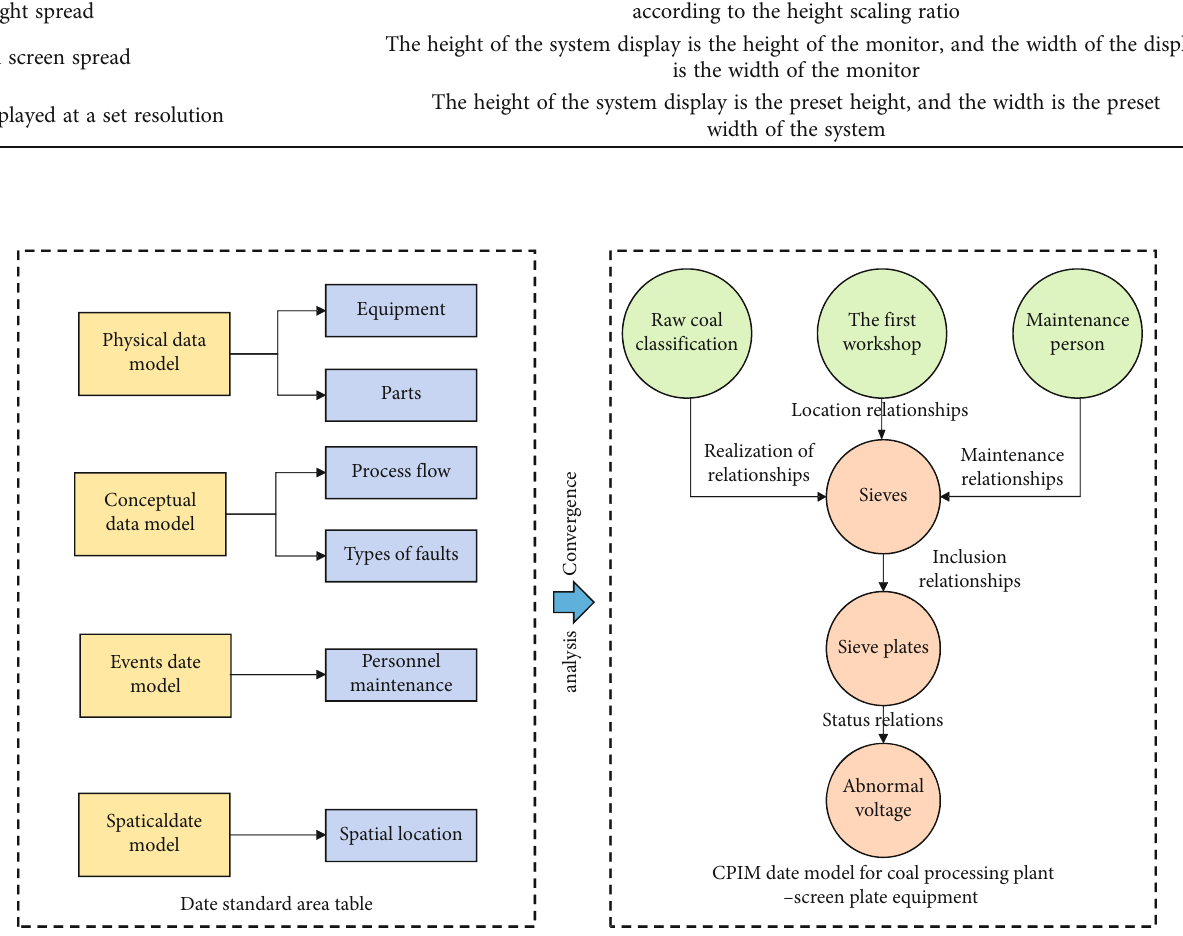
Figure 1: Coal processing plant multimodal data association fusion analysis platform data system